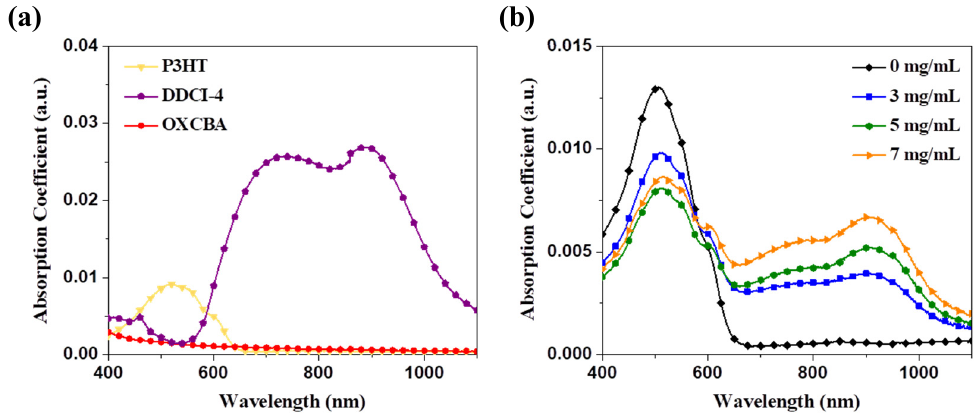
Figure 2. ( a ) P3HT, DDCI-4, OXCBA Vis–NIR absorption spectra; ( b ) Blended ratio Vis–NIR absorption spectra.